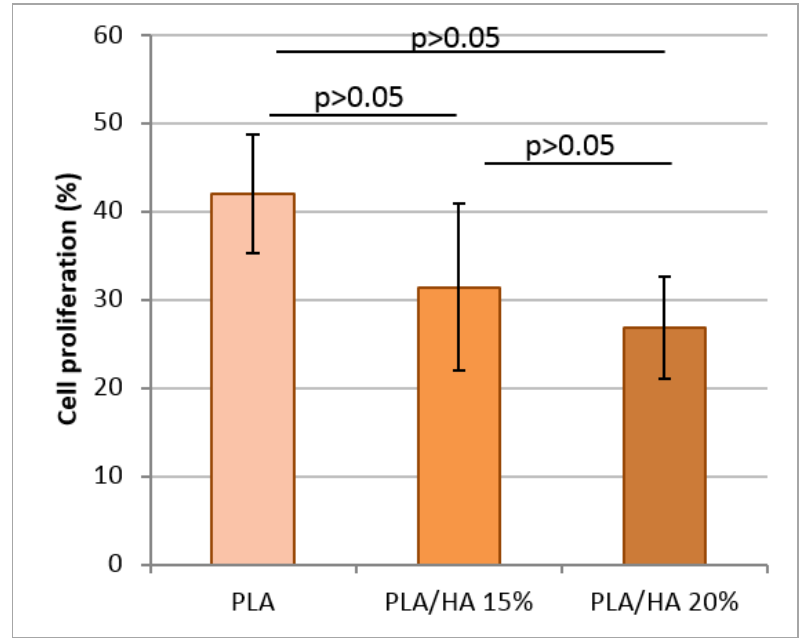
Figure 6. Percentage MMSC proliferation on PLA, PLA/HA 15%, and PLA/HA 20% scaffolds after cultivation for 2 days at 37 °C in 5% carbon dioxide.